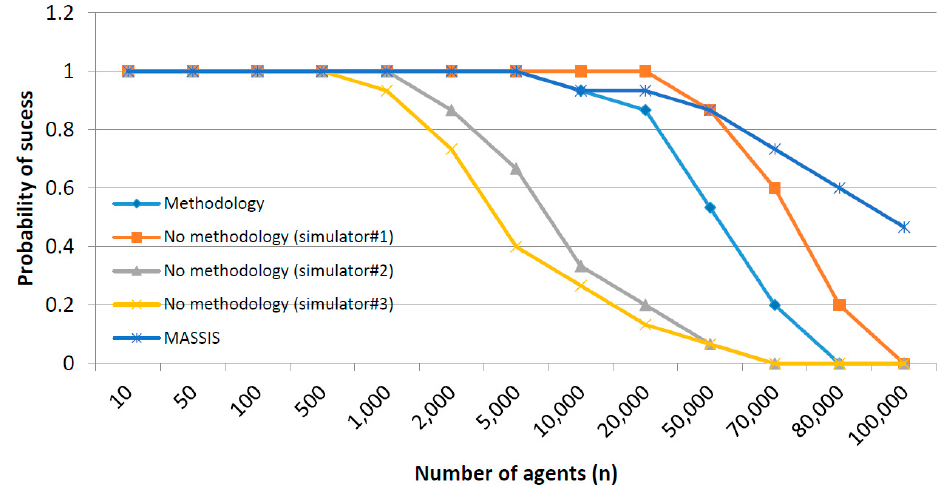
Figure 18. Scalability of the proposed co-simulators considering the number of agents.